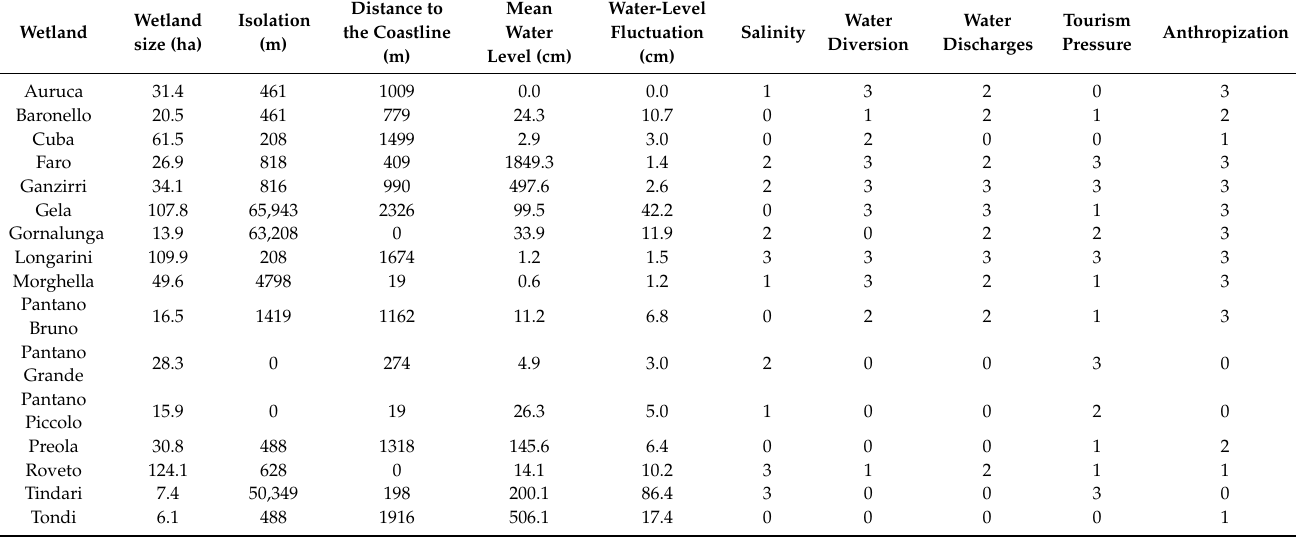
Table 1. Attributes of the 16 wetlands under study in Sicily (Italy). The last five attributes were measured on a semi-quantitative scale of 0 to 3 (0 if it was absent, 1 if localized, 2 if scattered and 3 if widespread), using both technical (the authors) and local (the natives, local policymakers and landowners) expertise. Refer to Table S2 for a detailed description of each